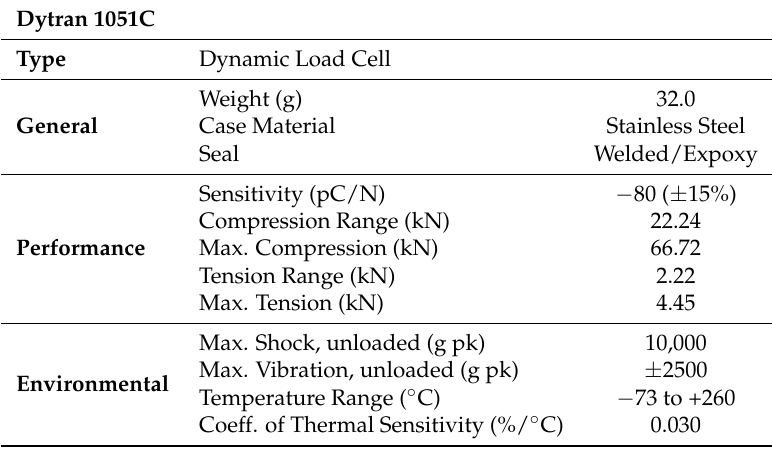
Table A2. Technical specifications of the dynamic load cell Dytran 1051C.